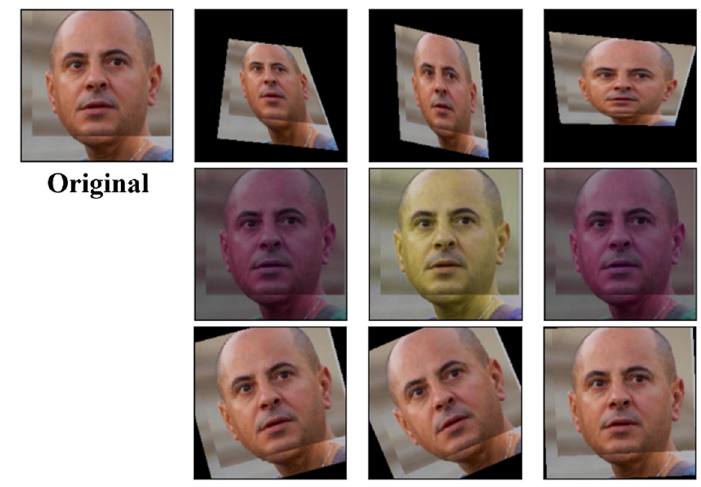
Figure 3. Image generated by various augmentation methods, such as random perspective, color jitter, and rotation.